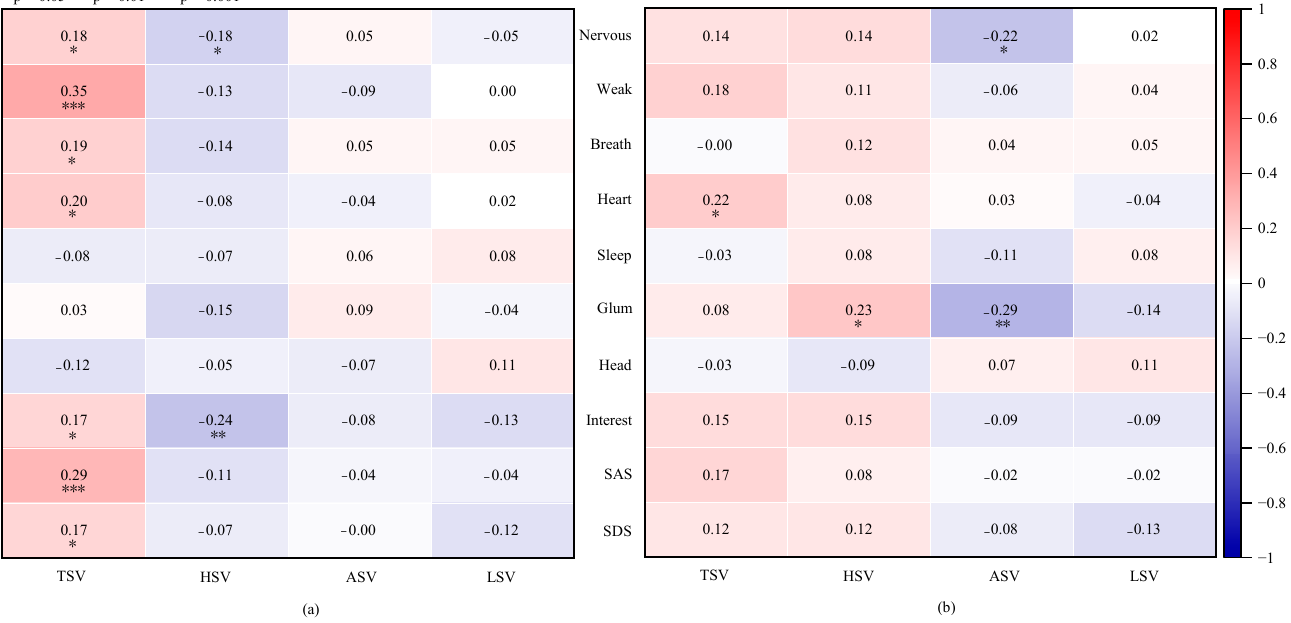
Figure 9. Results of the correlation analysis between environmental sensation and psychological state during the ( a ) early and ( b ) late isolation stages.